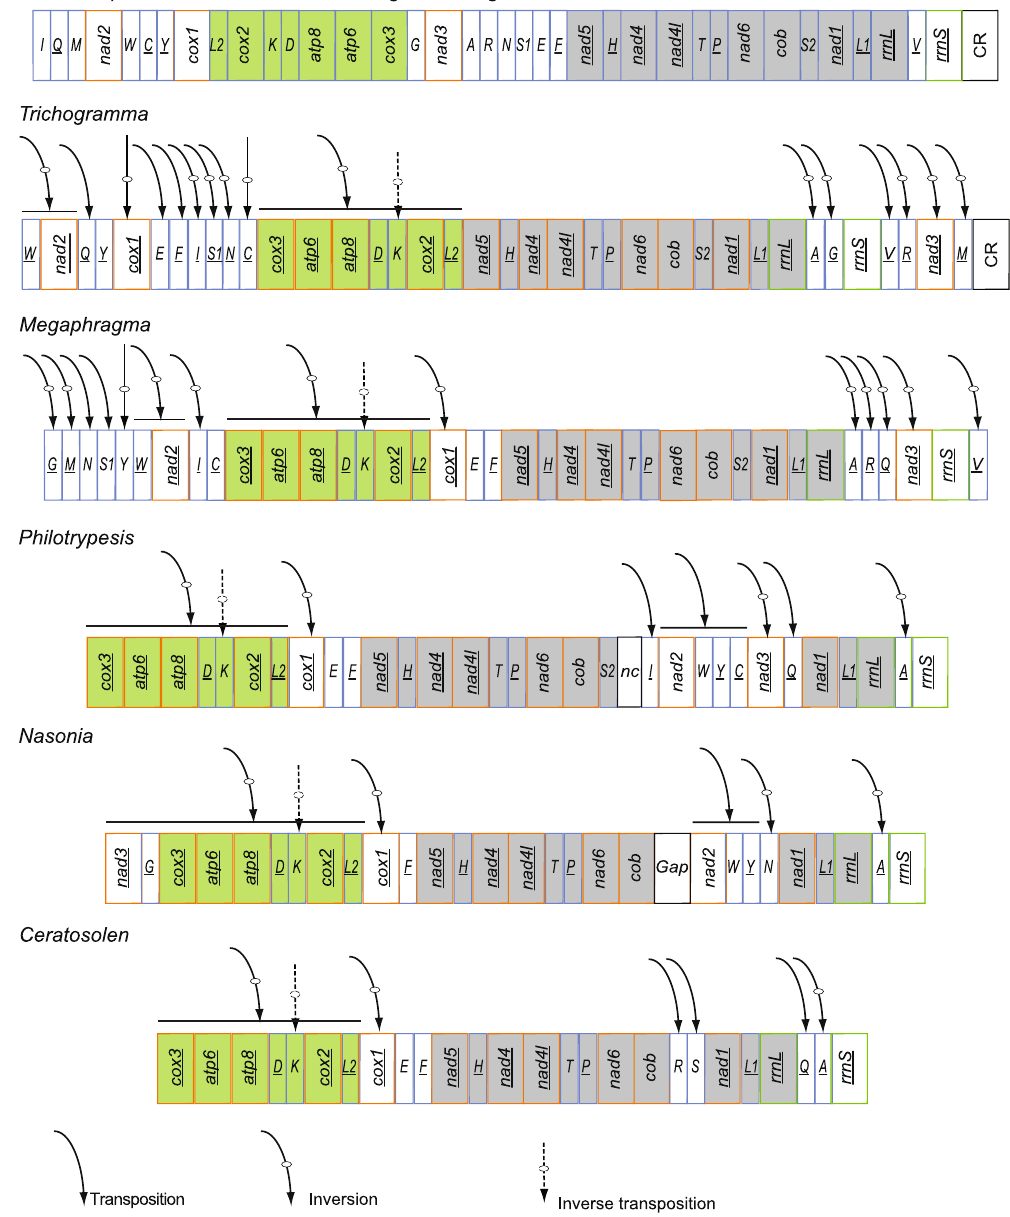
Figure 2. Mitochondrial genome organization and gene rearrangement in Chalcidoidea compared with the ancestral type of the insect mitochondrial genome. The gene order is linearized for easy view. The gene blocks with inversion are shown in green, while the conserved gene blocks are showed in grey. Genes nomenclature: atp6 and atp8 ; ATP synthase subunits 6 and 8; cob : cytochrome b; cox1 – 3 : cytochrome c oxidase subunits 1–3; nad1 – 6 and nad4L : NADH dehydrogenase subunits 1–6 and 4 L; rrnS and rrnL : small and large subunit ribosomal RNA (rRNA) genes; Transfer RNA genes are denoted by a one-letter symbol according to the IPUC- IUB single-letter amino acid codes. L1, L2, S1 and S2 denote tRNAL (CUN), tRNAL (UUR), tRNAS (AGN) and tRNAS (UCN), respectively. CR indicate the control